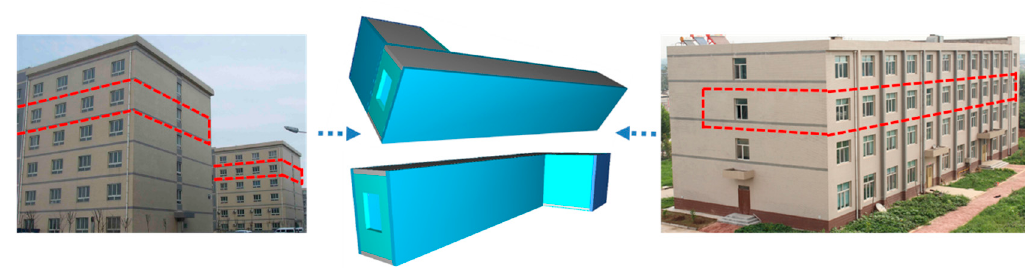
Figure 1. The typical room–corridor structure in buildings.